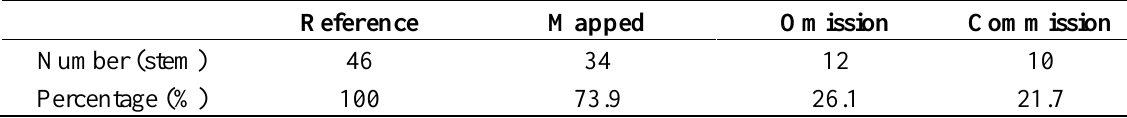
Table 6. Stem mapping accuracy utilizing the merged PLS data.